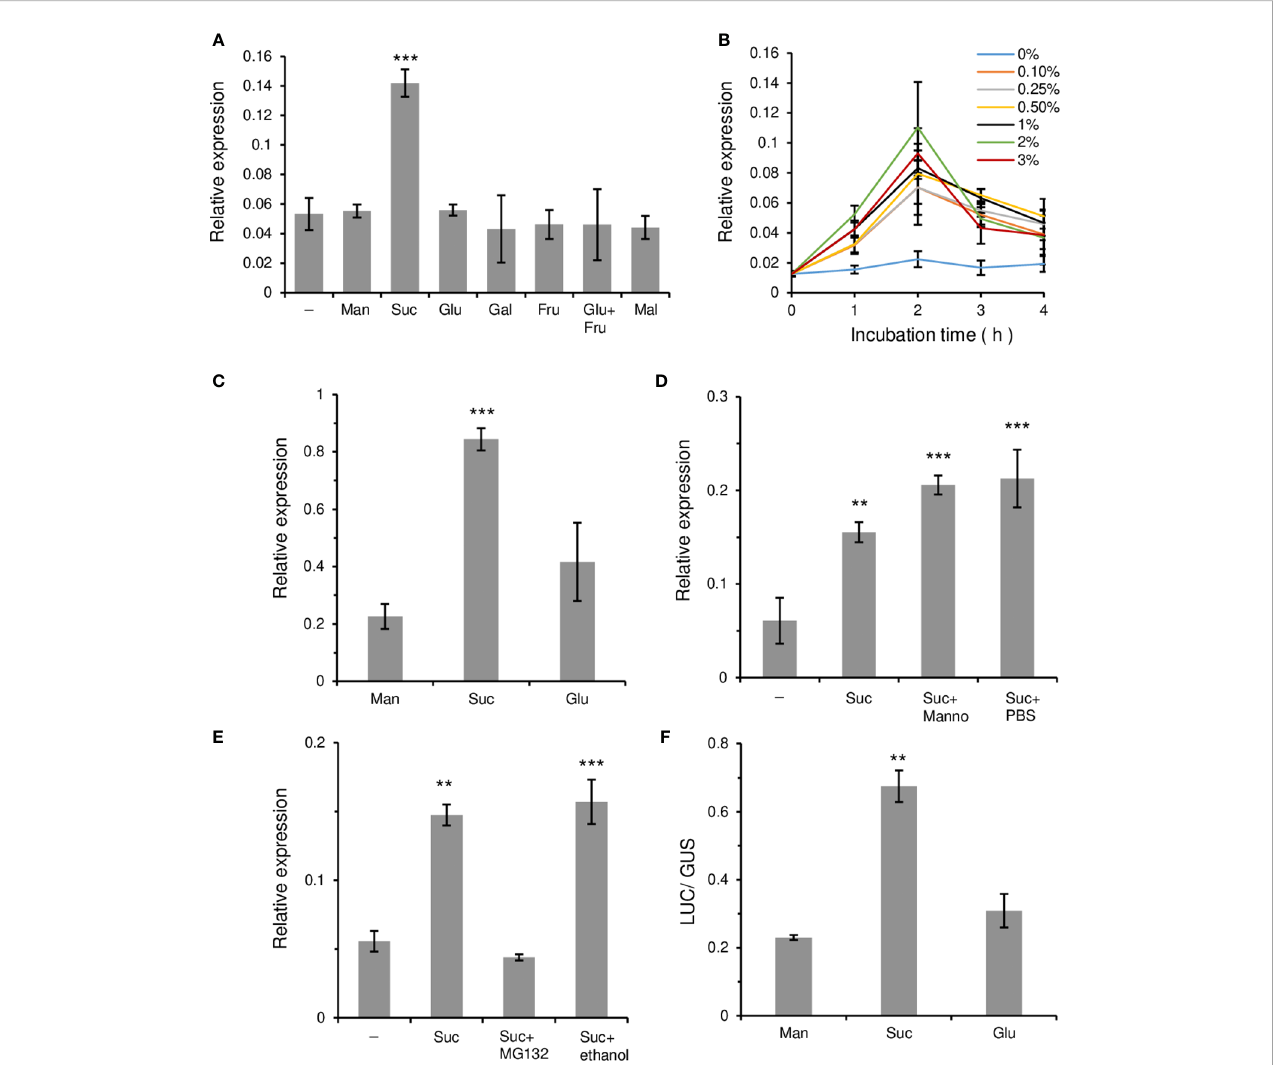
FIGURE 2 Relative transcripts level of OsWRKY7 affected by various sugars and inhibitors. (A-D) Effects of various sugars and chemicals. (A) Effect of sugars at 3% concentration in Oc cells. Samples were collected at 2 hours after sugar addition. (B) Effect of different sucrose concentrations. (C) Effect of 3% sugars in roots of 14-d-old seedlings. (D) Effects of 5 µM mannoheptulose (Manno). Effect of PBS was tested because mannoheptulose was dissolved in PBS before adding to the sucrose-containing medium. (E) In fl uence of MG132. Samples were collected at 1 hours after addition of 3% sucrose, 3% sucrose plus 100 µM MG132, or 3% sucrose plus 0.5% ethanol. We tested the effect of ethanol because MG132 was dissolved in ethanol. (F) Luciferase activity driven by the OsWRKY7 promoter and LUC coding region. ZmUbi::GUS construct was used as an internal control. Man, mannitol; Suc, sucrose; Glu, glucose; Gal; galactose; Fru, fructose; Mal, maltose. Minus sign (-) means basal media. Gene expression levels are relative to those of OsActin1. The error bars indicate standard deviations; n = 3 or more. Statistical signi fi cance is indicated by **(P < 0.01) and ***(P <